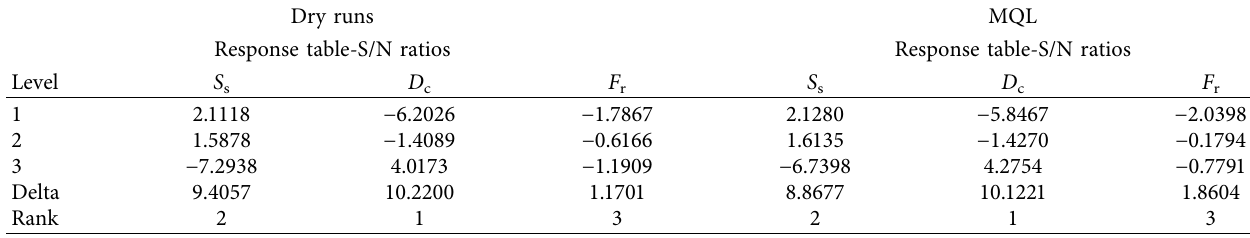
Table 9: Response table for S/N ratios (MRR).